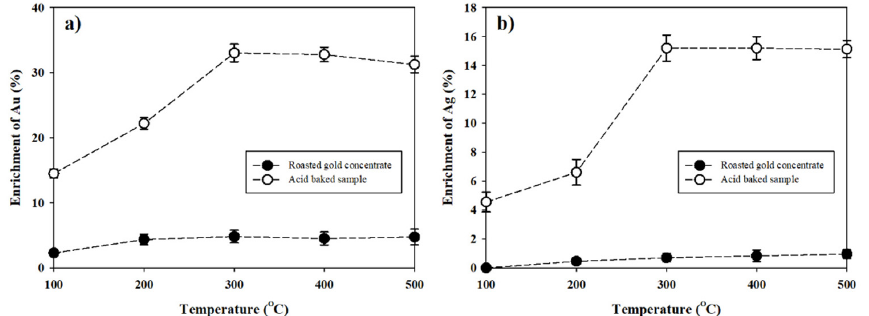
Figure 7. Enrichment of ( a ) Au and ( b ) Ag on the solid residue from hot water leaching after acid baking at different temperatures (from 100 °C to 500 °C).